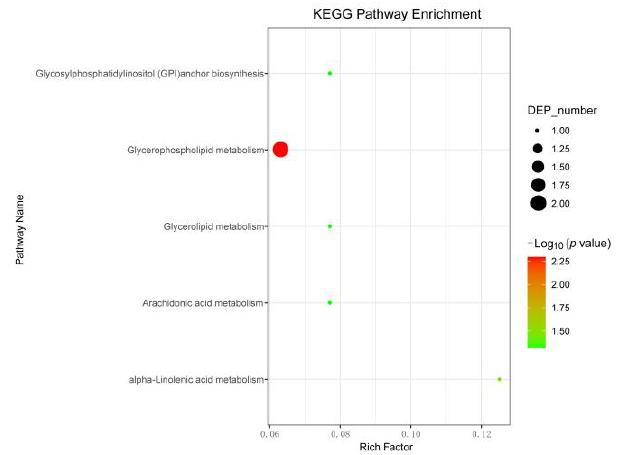
Figure 9. Pathway analysis associated with CSBV infection was carried out by MetaboAnalyst. The Y -axis, “Log10 ( p )”, represented the transformation of the original p -value calculated from the enrichment analysis. The X -axis represents the pathway impact value calculated from the pathway topology analysis, and larger bubbles represent higher pathway impact values.